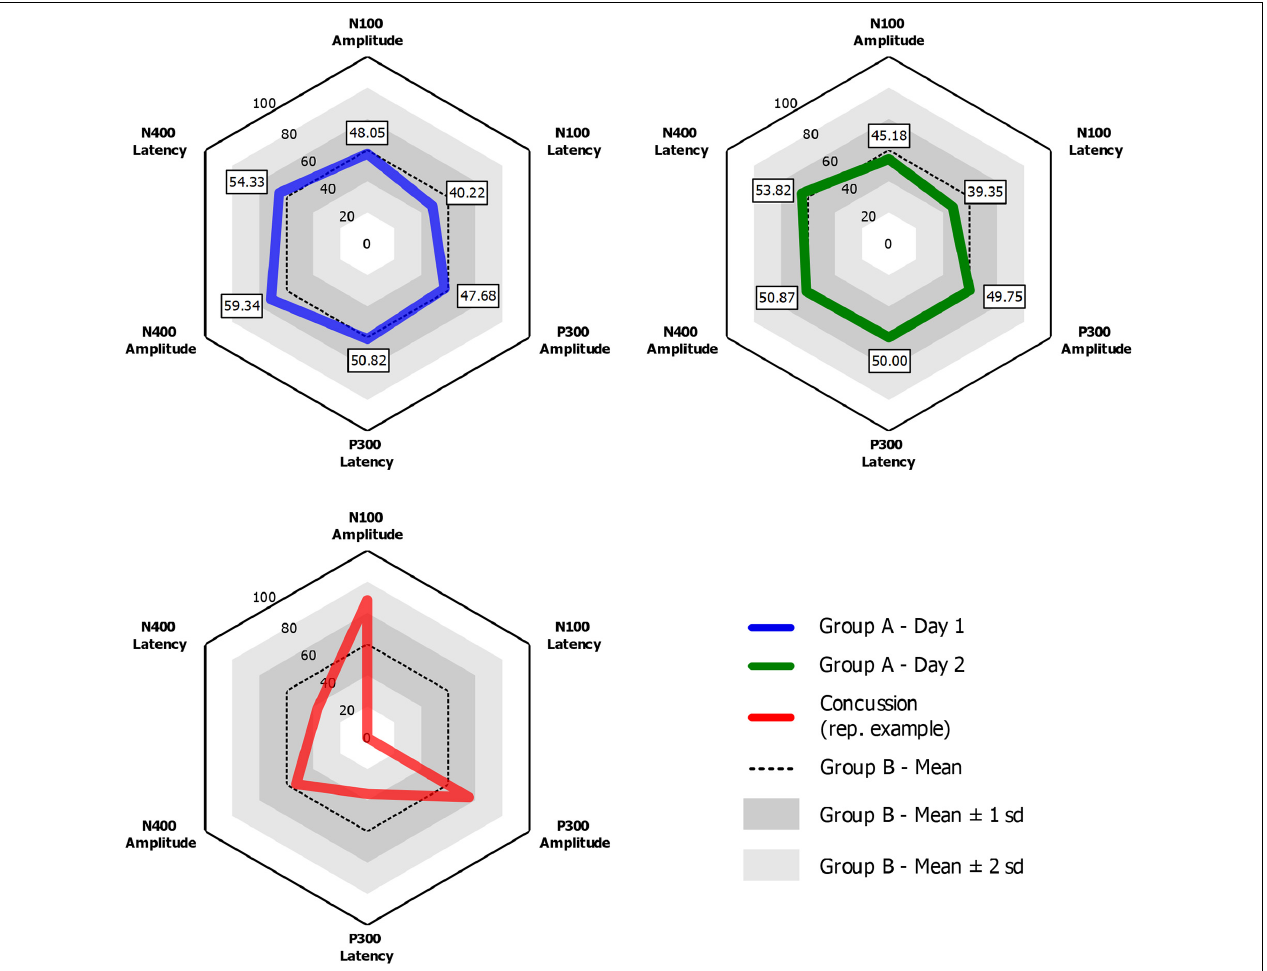
FIGURE 3 | Radar plots for Group A Time 1 (Blue) and Group A Time 2 (Green) showing group-mean elite athlete normalized brain vital signs scores compared to Group B, a general reference database of 135 participants of all ages and sexes. An example radar plot of data from a single concussed ice-hockey athlete for comparison (adapted from Fickling et al.,